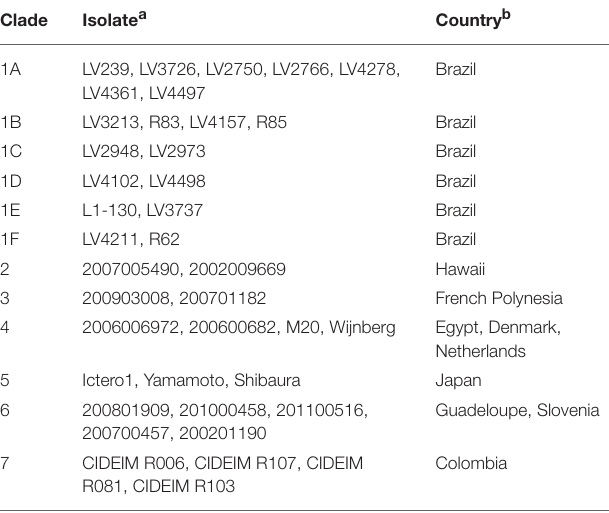
TABLE 3 | Correlation of isolates based on the geographical clades from phylogenetic analysis. Clade Isolate a Country b